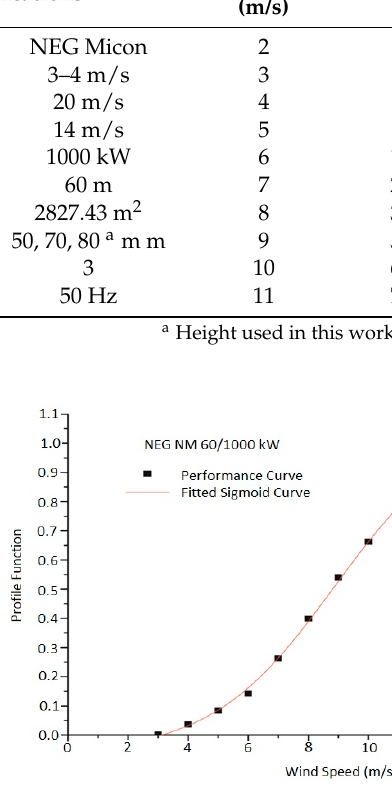
Table 6. Selected wind turbine technical specifications. Figure 4. Power densities computed using MEP ‐ based functions at orders 5, 6, 7 and 8, Weibull function and actual wind speed data.